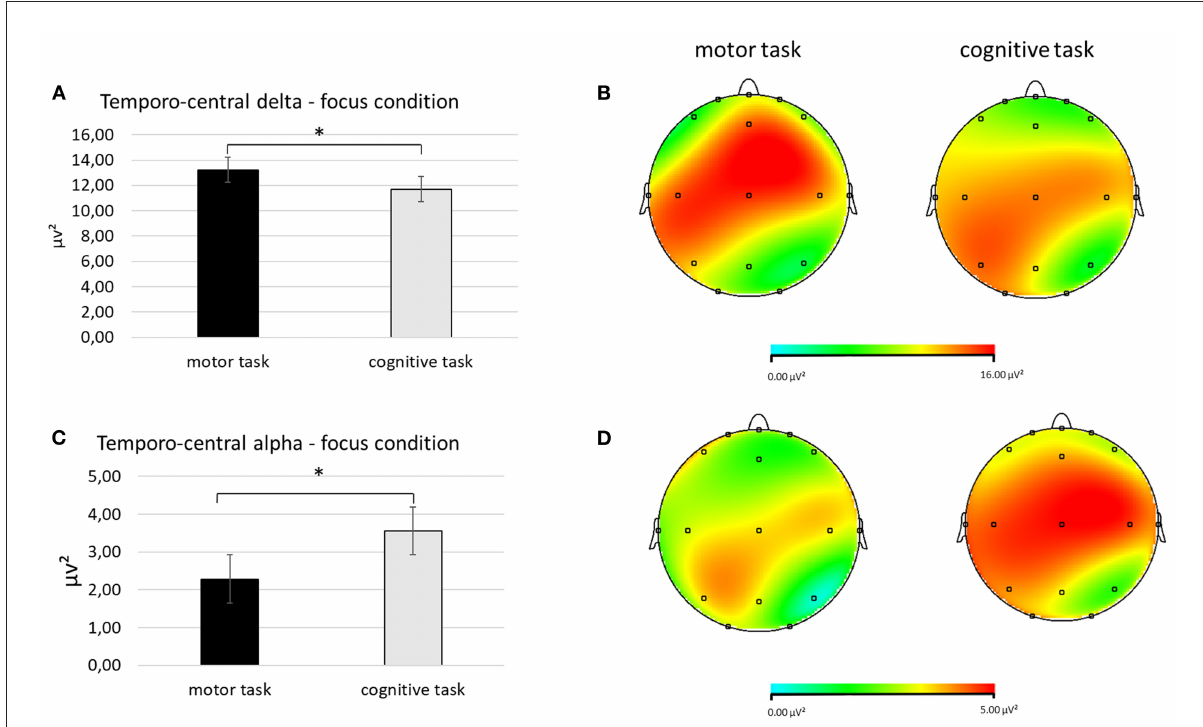
FIGURE3 (A–D) Electrophysiological outcomes for delta and alpha bands. (A) The bar chart shows temporo-central delta mean values in the focus condition during the two synchronization tasks. (B) The red area represents greater delta power in the focus condition during the motor (left head) compared to the cognitive synchronization task (right head). (C) The bar graph displays the significant increase of temporocentral alpha values in the focus condition when performing the cognitive compared to motor synchronization task. (D) The red area represents greater alpha power in the focus condition during the cognitive (right head) compared to motor synchronization task (left head). For all charts, bars indicate ± 1 Standard Error (SE); all asterisks mark statistically significant differences, with p ≤